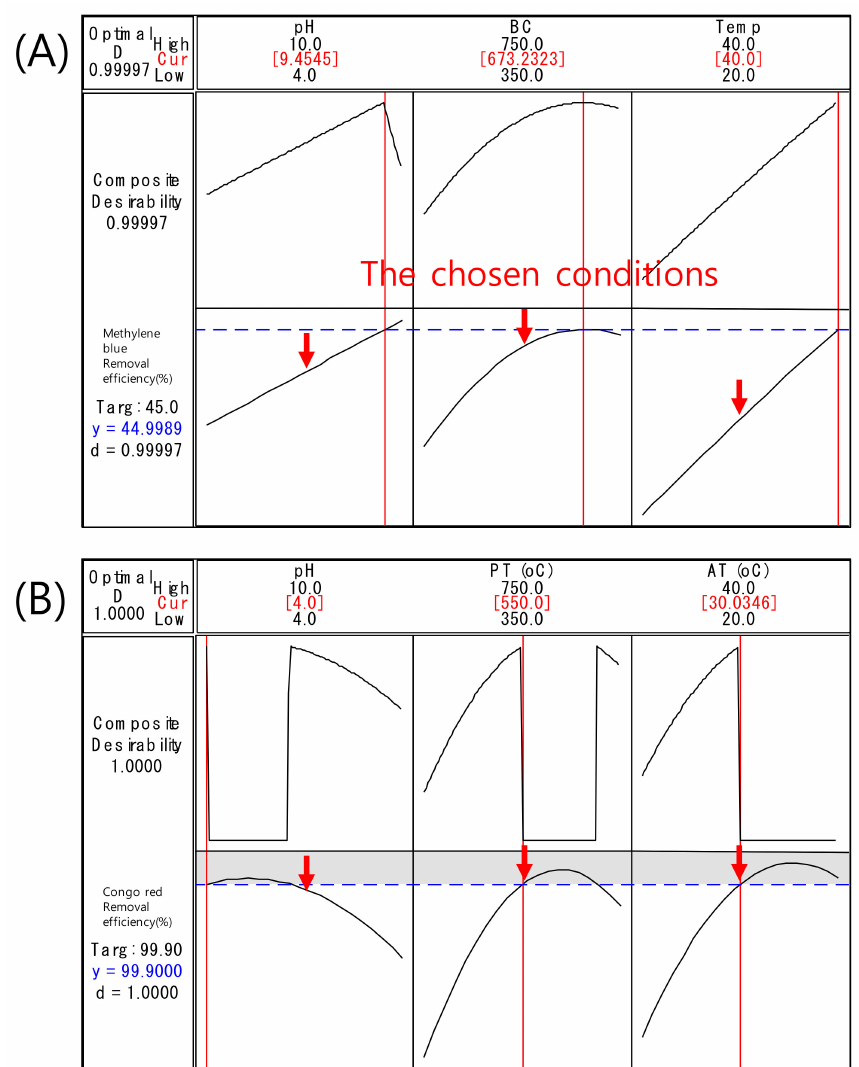
Figure 2. Predicted values of di ff erent variables (pH, pyrolysis temperature (PT, ◦ C), and adsorption temperature (AT, ◦ C)) for optimum adsorption e ffi ciency. ( A ): MB, ( B ): CR). Symbol ( ↓ ) is the chosen conditions for the adsorption of mixtures of MB and